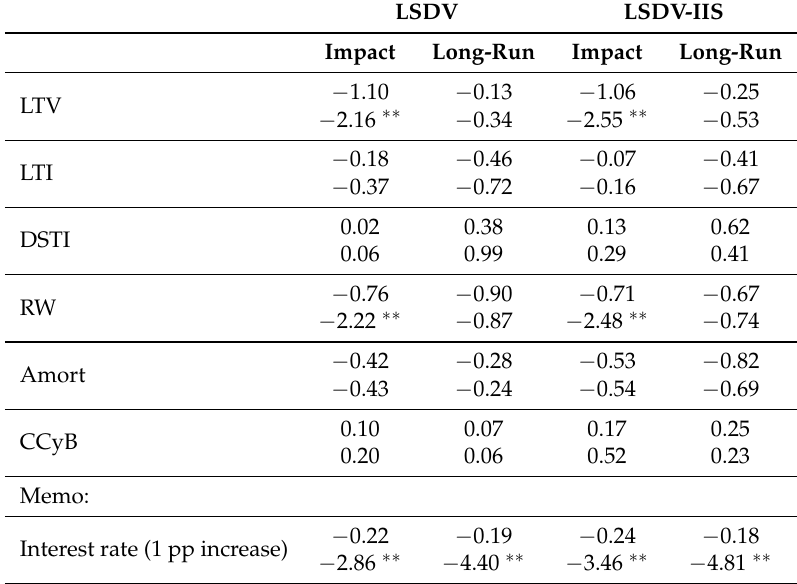
Table 6. Real house price change. Estimated (LSDV and LSDV-IIS) effects for LTV, LTI, DSTI, RW, Amort and CCyB . Results for the central bank rate shown in the memo part of the table. t-values are shown below the estimated impact and long-run effects. Statistical significance (two sided test) is indicated by ∗∗ (5% level) and ∗ (10%